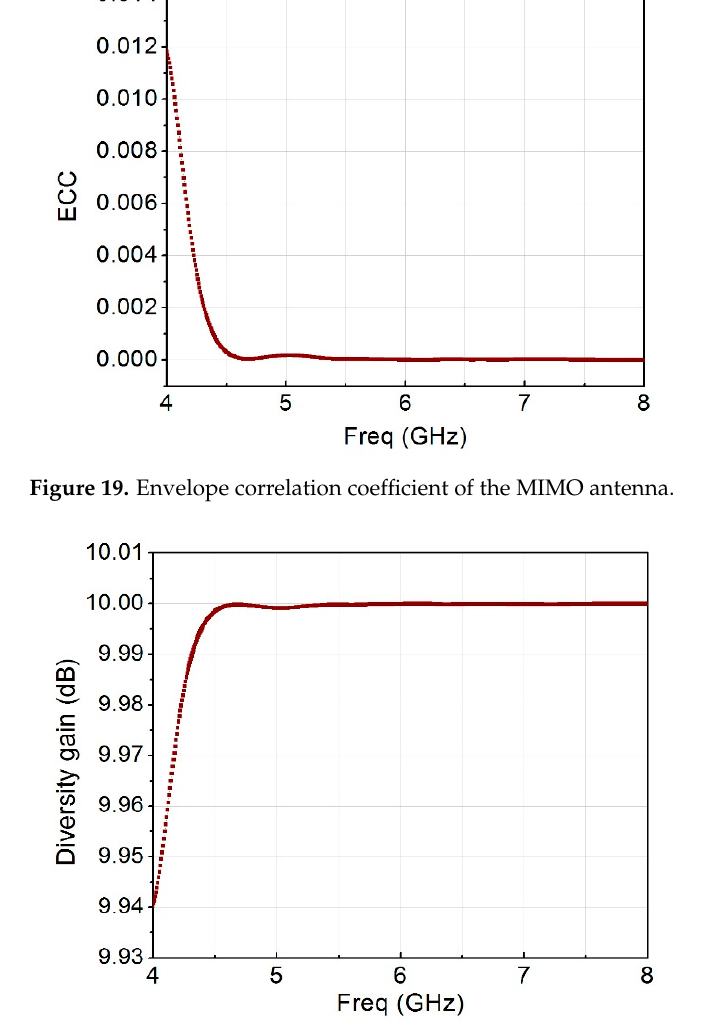
Figure 21. Maximum gain over frequency.